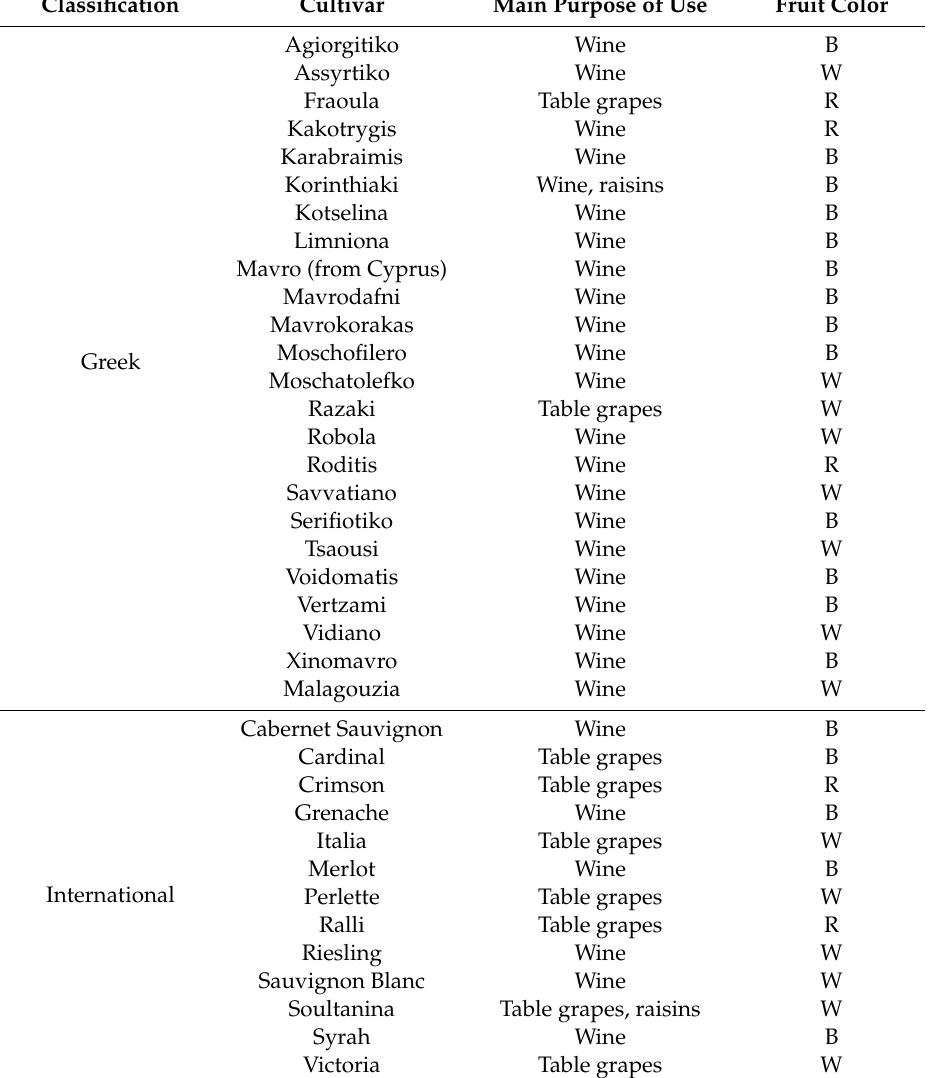
Table 1. List of cultivars analyzed. Fruit color is presented as B, black; R, red; W, white. Classification Cultivar Main Purpose of